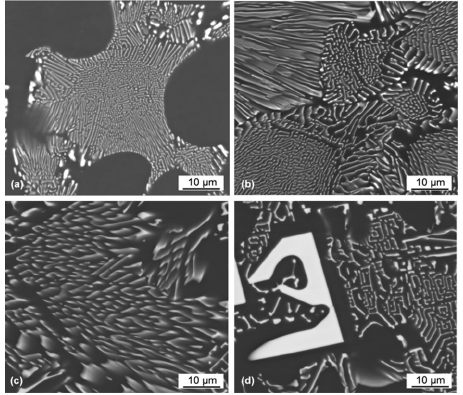
Figure 8. SEM magnified views of morphological changes of the Al 11 Ce 3 eutectic phase with Ce